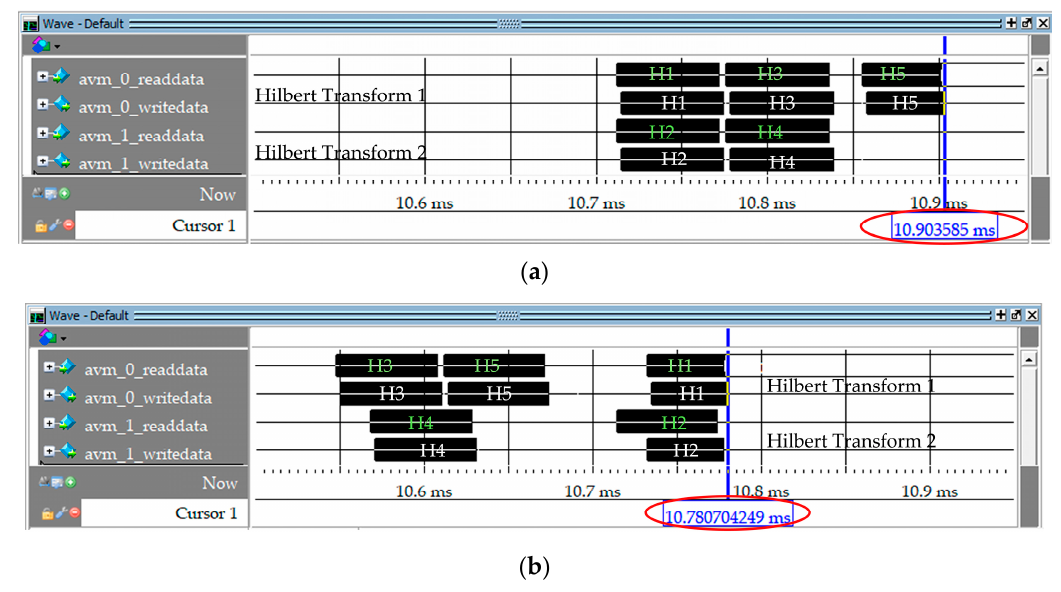
Figure 15. Hilbert transform scheduling simulation in ModelSim: ( a ) HEFT and ( b ) HPEFT.